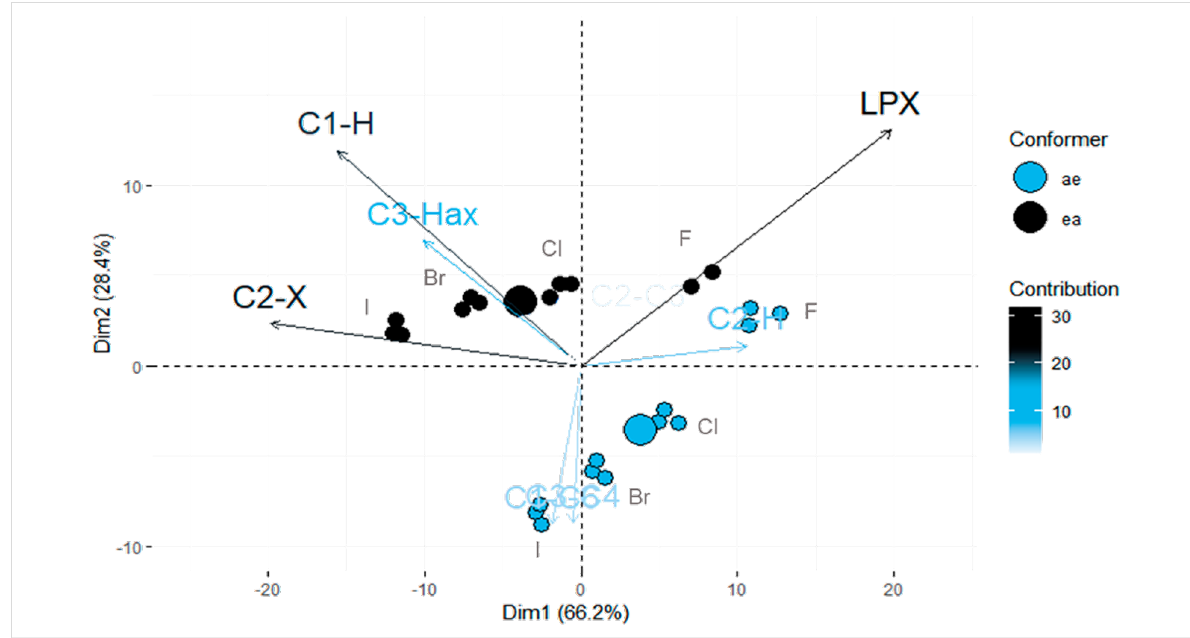
Figure 6: PCA for 22 variables corresponding to the hyperconjugative interactions for all rotamers in ae and ea conformers of cis -2-halocyclohexyl- amines. Note that the correlation vectors with the strongest black color has the greater contribution for the PC’s.